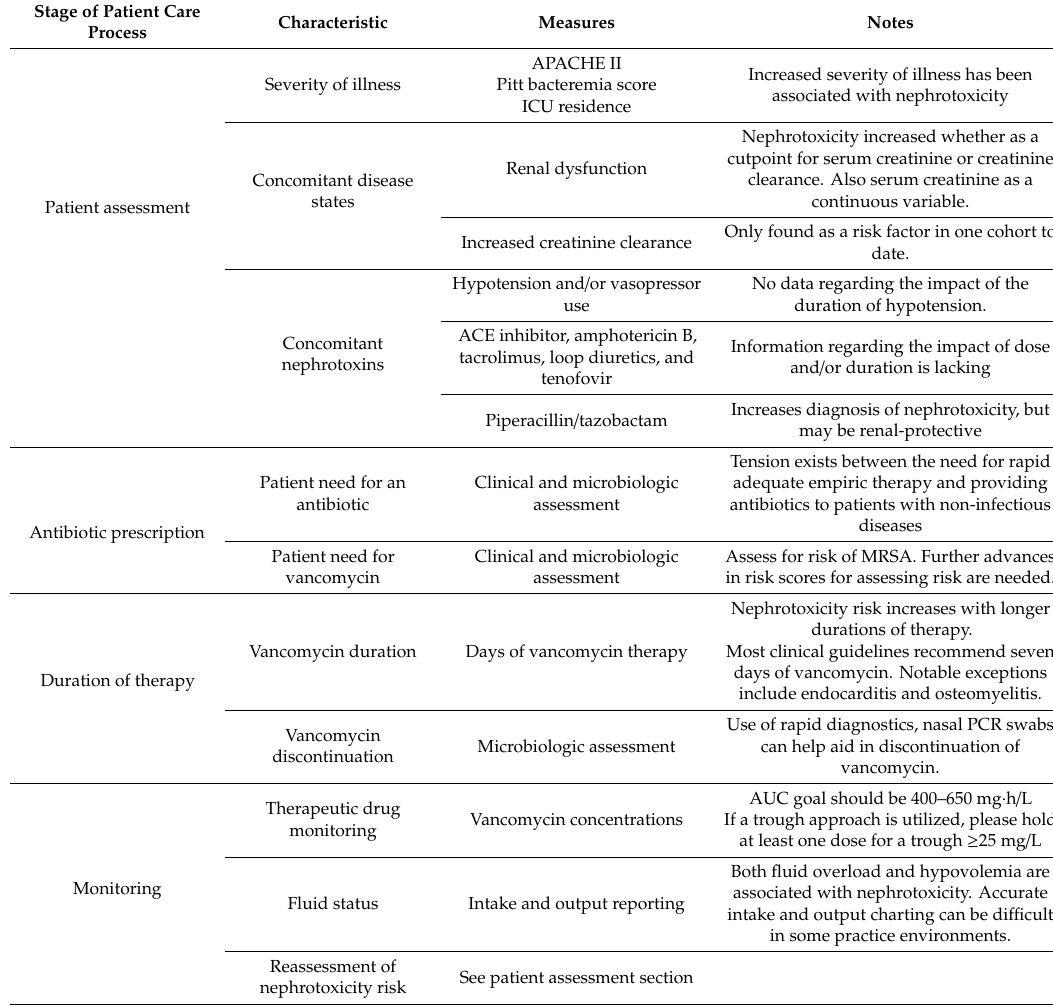
Table 1. Summary of the patient care process to assess the risk of nephrotoxicity in patients being considered for vancomycin